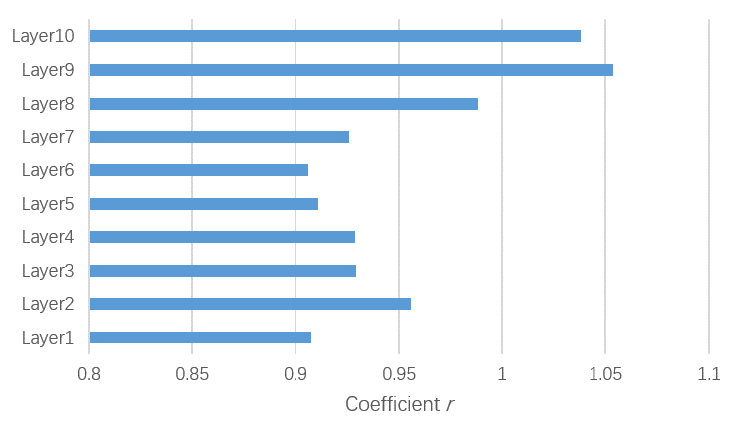
Figure 8. Visualization of the coefficient r of each layer.